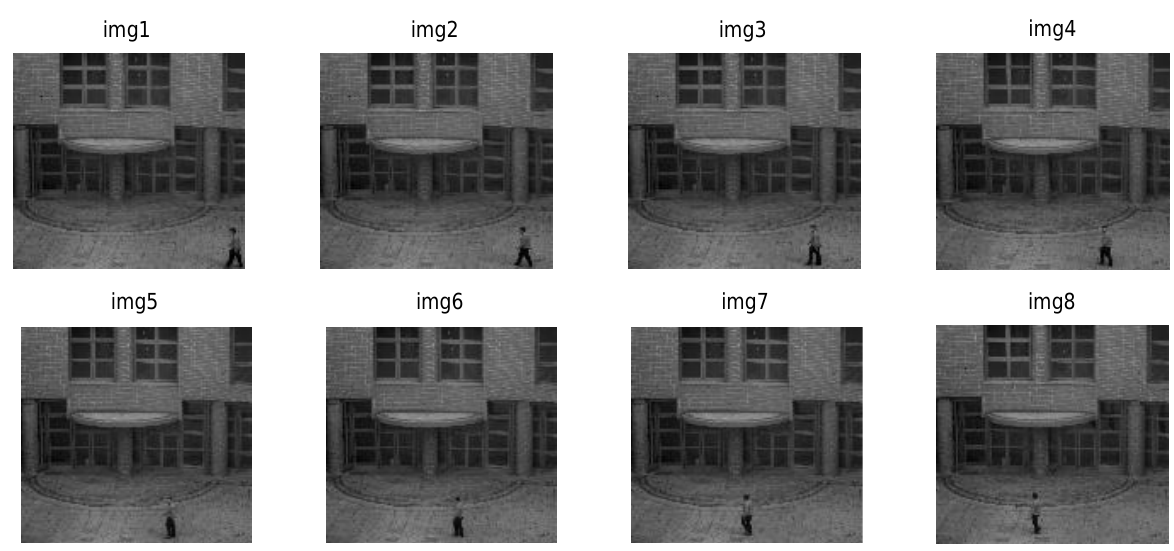
Figure 9. Sequence of images captured to determine new